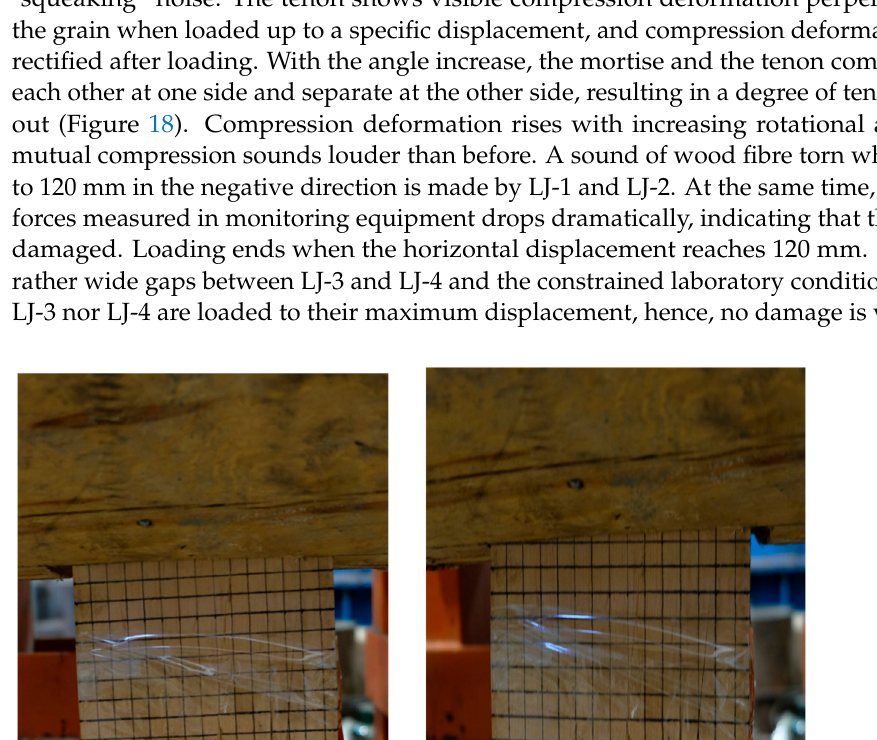
Figure 16. Loading program of horizontal displacement.